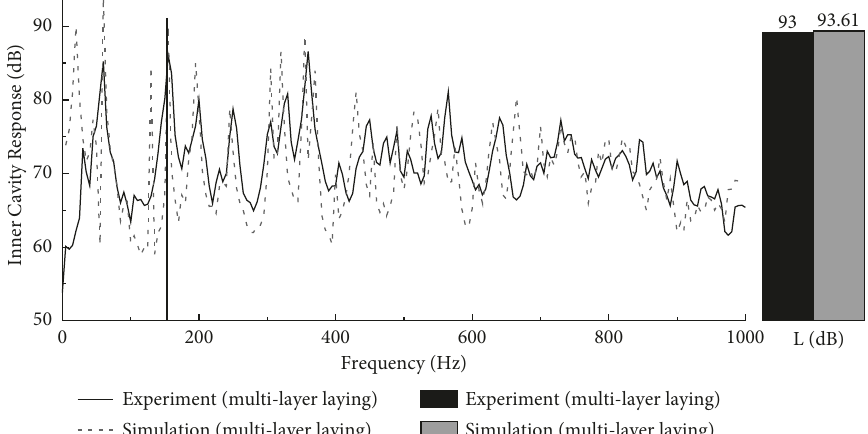
Figure 7: Comparison of the internal response spectrum achieved from the experiment and simulation with the laying of a multilayer material. Table 4: Comparison of total SPL between the experiment and simulation of the cylindrical shell with different acoustic materials. Acoustic material type Experiment SPL (dB) Melamine foam Sound-absorbing cotton Multilayer